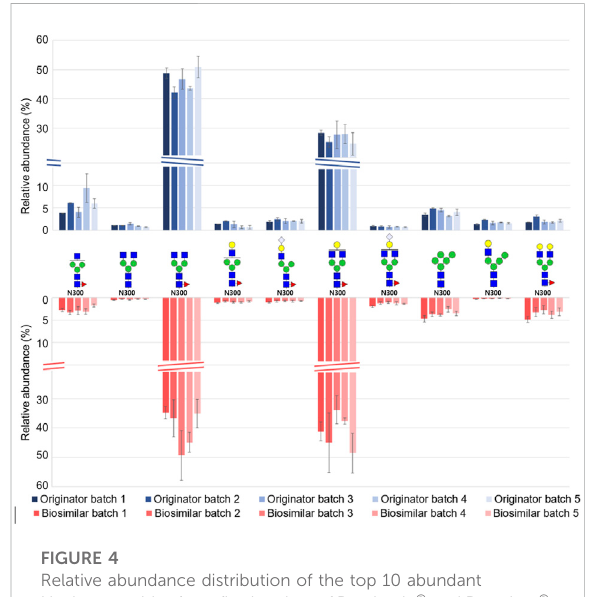
FIGURE 4 Relative abundance distribution of the top 10 abundant N-glycopeptides from fi ve batches of Remicade ® and Remsima ® .